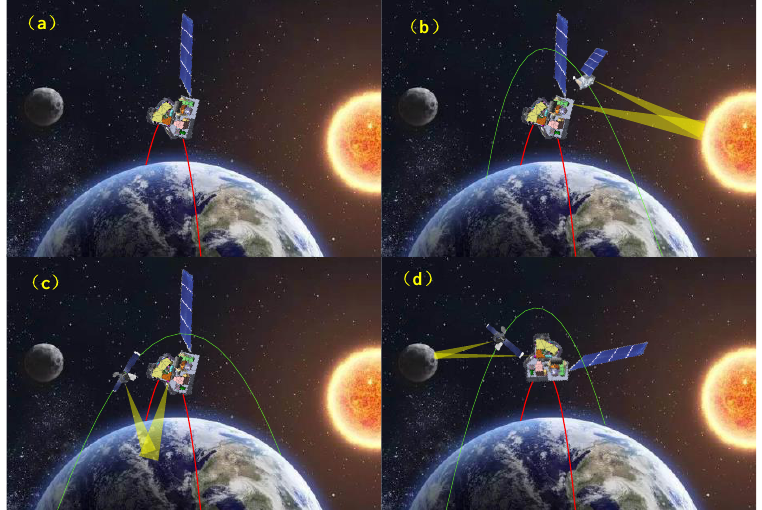
Figure 1. The working model of the radiometric benchmark satellite: ( a ) self-calibration, ( b ) total solar irradiance calibration, ( c ) uniform field calibration, and ( d ) lunar calibration.